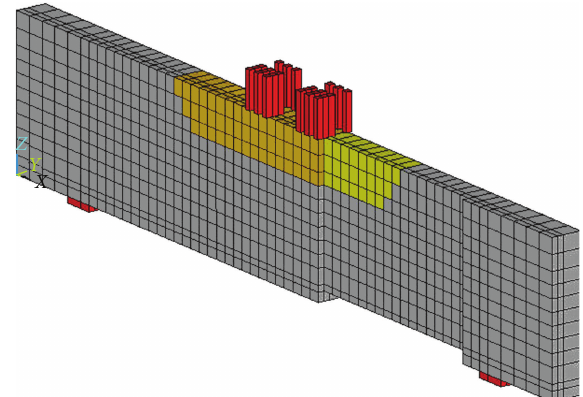
Figure 9: Corrosion-damaged finite element model with idealized concrete